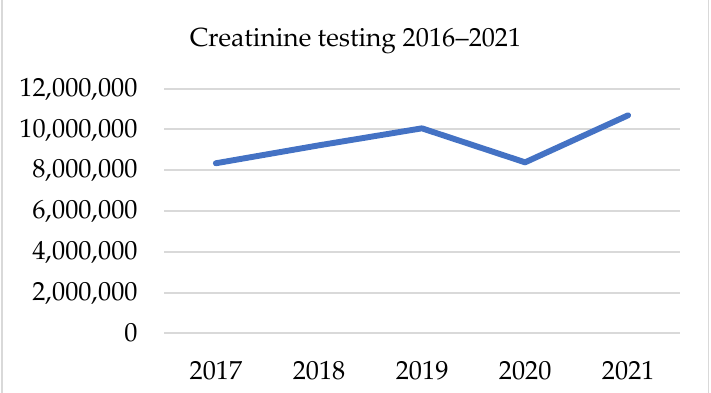
Figure 6. Creatinine testing in 2016 – 2021.